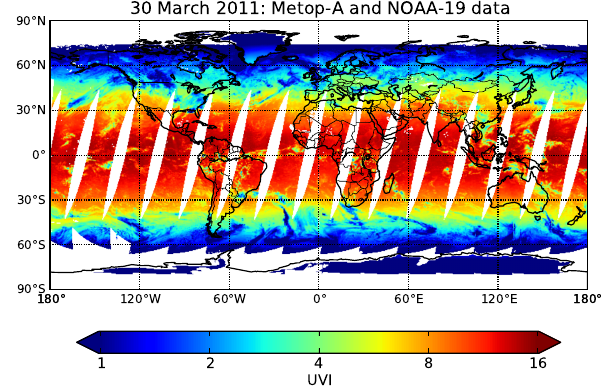
Figure 1. An example product field. Solar noon UV index de- rived from Metop-A and NOAA-19 data on 30 March 2011 dur- ing the Arctic ozone hole episode when exceptionally large val- ues of UV index for the point in time were observed in the Arc- tic. In Sodankylä, northern Finland, a solar noon UV index of 2.14 was measured at ground level exceeding the climatological value by 100% (Bernhard et al., 2013). A slightly smaller value of 1.9 is ob- tained from the OUV product due to averaging of cloud cover over a larger area than is seen by the ground-based instrument. Global coverage of the product is limited by the swath of the GOME-2 instrument leaving stripes at low latitudes. The polar night and the maximum solar zenith angle for cloud processing limit the coverage at high latitudes while cloud-free values are used for the Antarctic and Greenland ice